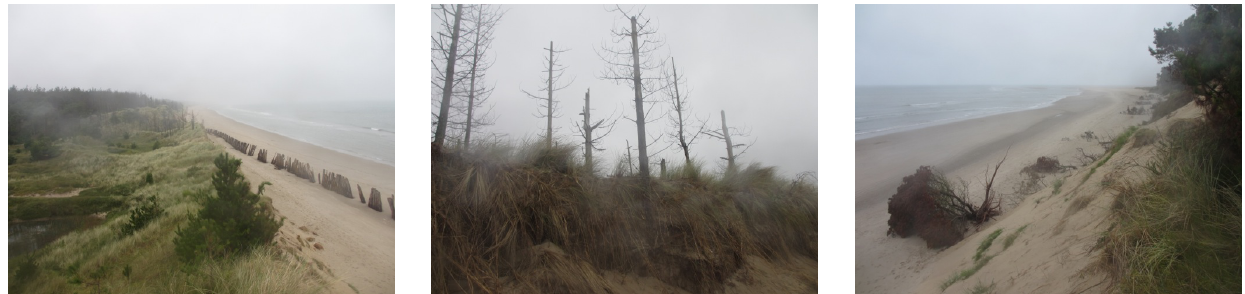
Figure 10. Pictures of the sand dunes at Culleton’s Gap, Co. Wexford, taken on 18 September 2016, approximately 1 month after the gales (source: James